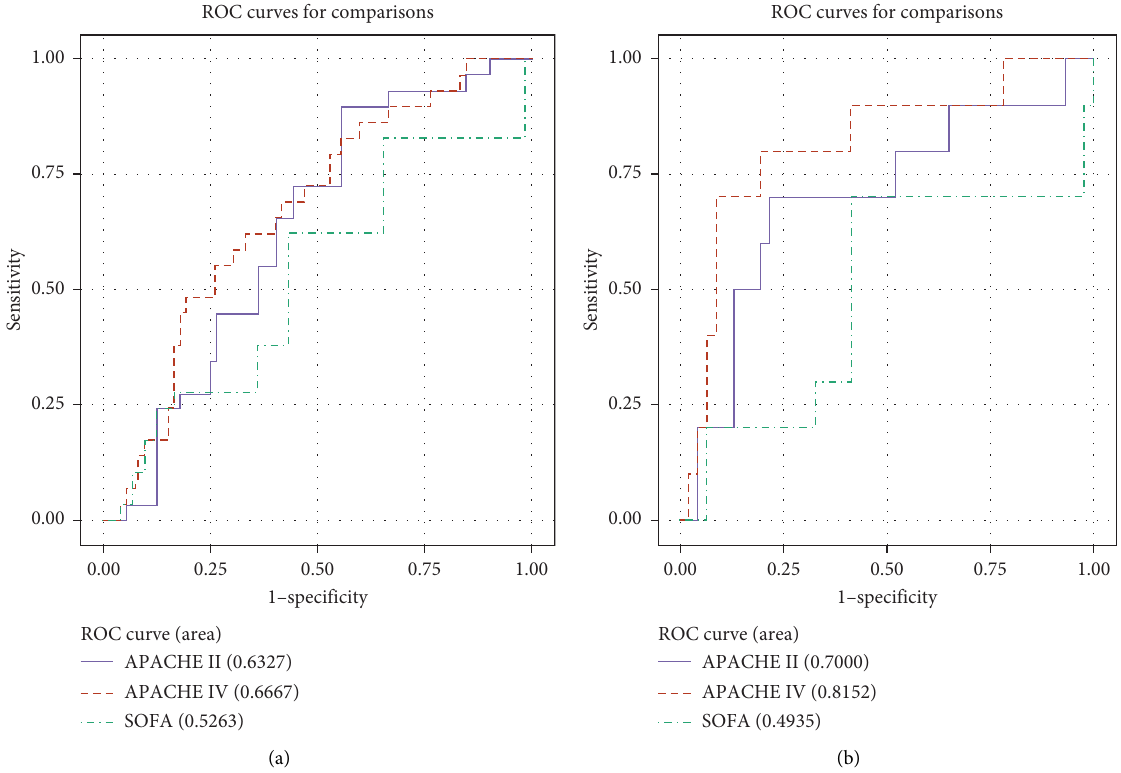
Figure 2: Ten-fold cross-validated ROC curves for the overall group (a) and current treatment group (b).